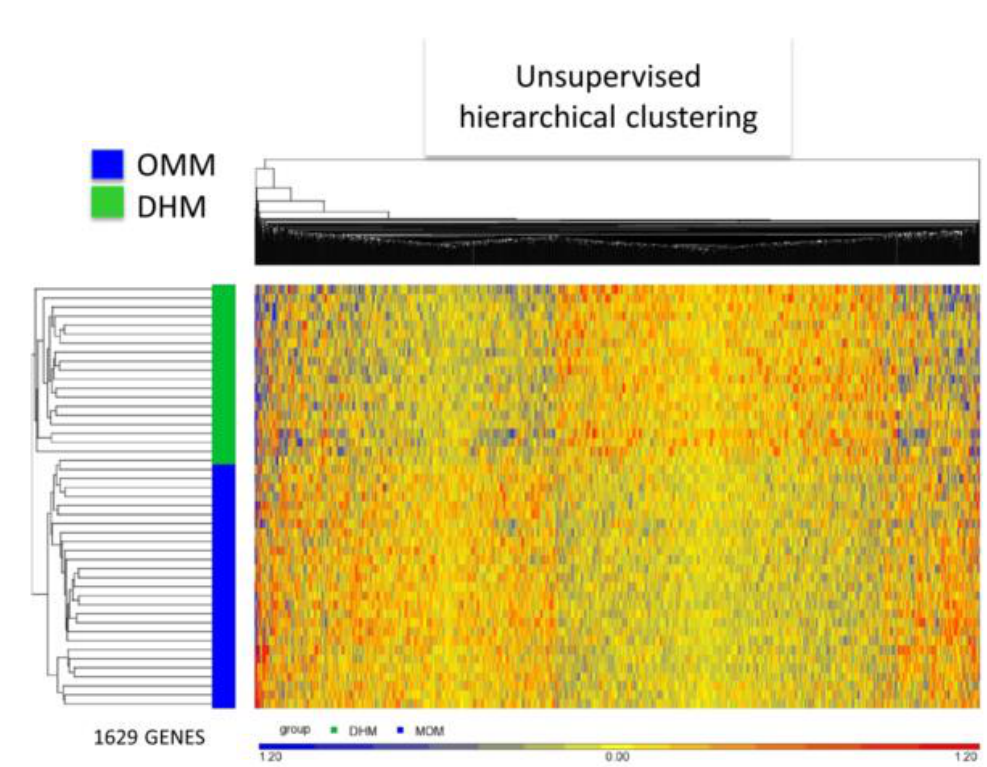
Figure 3. Heatmap of 27 preterm infants fed their own mother’s milk (OMM; blue bar) and 20 preterm infants fed donated human milk (DHM; green bar) and 1629 genes derived from ANOVA. Each line represents a patient and each column a gene. Overexpressed genes are represented in red and underexpressed genes in blue.